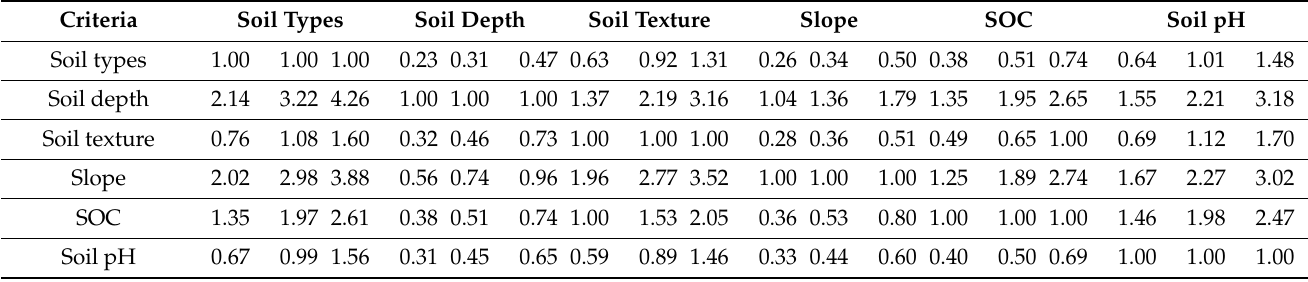
Table 7. The pairwise comparison matrix by